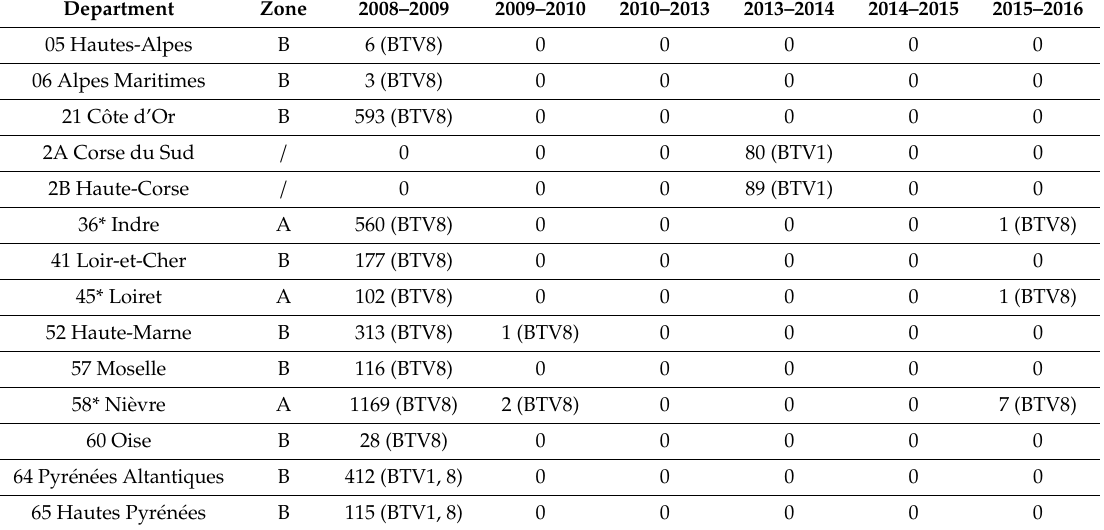
Table 1. Number of domestic Bluetongue virus (BTV) outbreaks occurring in domestic farms within the 15 departments considered in the study. “Dep” corresponds to the department number (located in Figure 1). No BTV outbreak was observed from 2010 to 2013. Zone A corresponds to BTV8 re-emergence in livestock in 2015, while Zone B corresponds to the continental departments with no apparent re-emergence. * departments with BTV8 outbreaks in domestic ruminants in